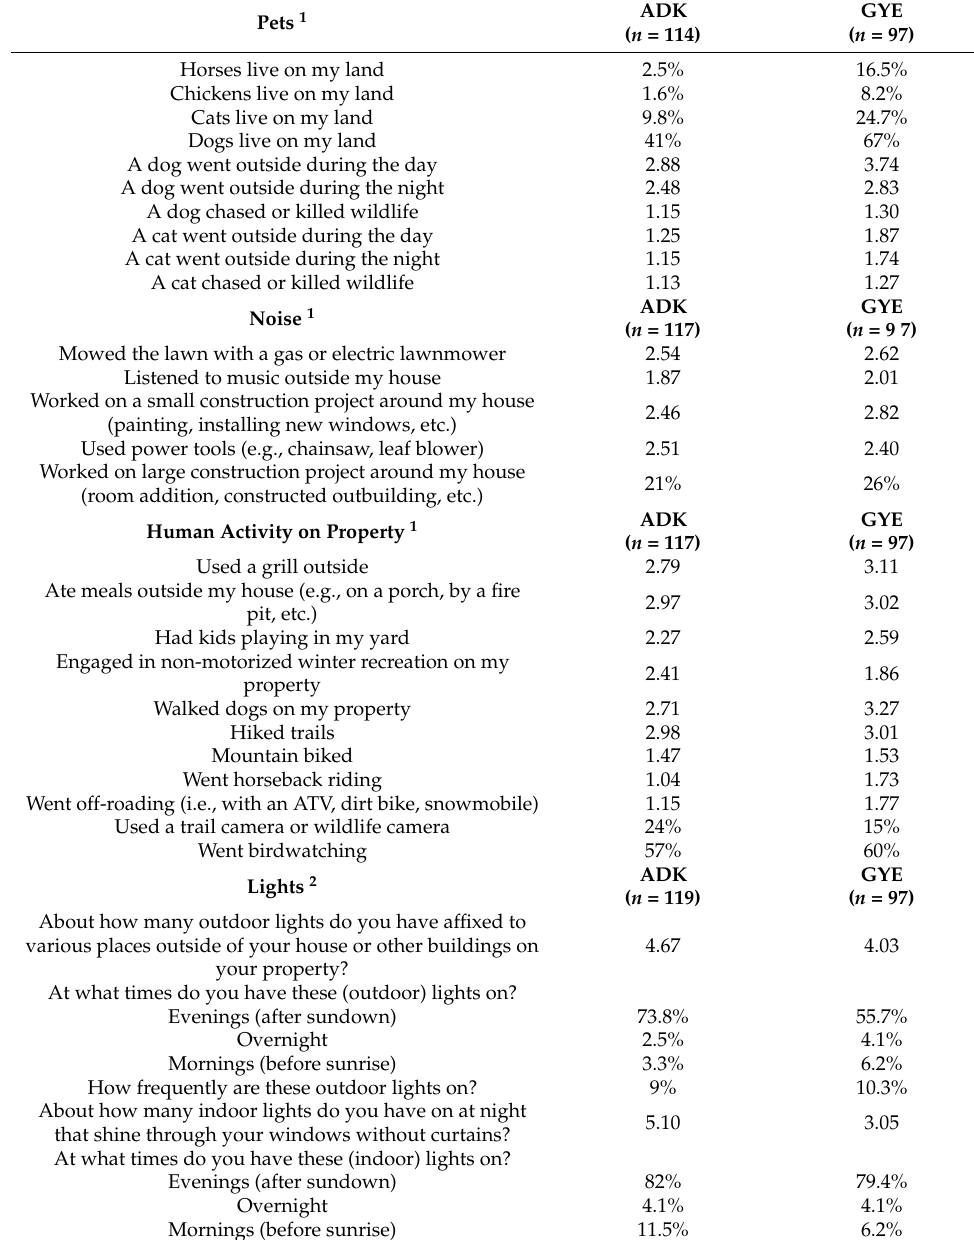
Table 4. Survey responses of landowners in Essex County, NY (ADK) and Madison County, MT (GYE) to questions pertaining to potential disturbances to wildlife; n = number of respondents to each question within each